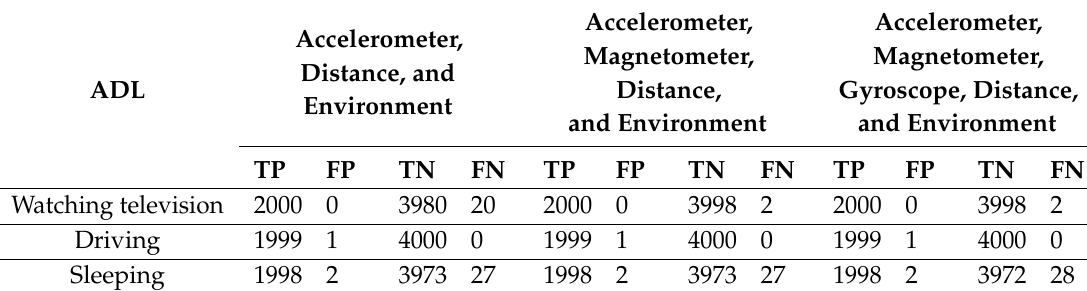
Table 20. Confusion matrix values of the recognition of activities without motion using the AdaBoost with the decision tree implemented with the SMILE framework for motion, magnetic, and location sensors after the recognition of the environment (TP = True Positive; TN = True Negative; FP = False Positive; FN = False Negative).